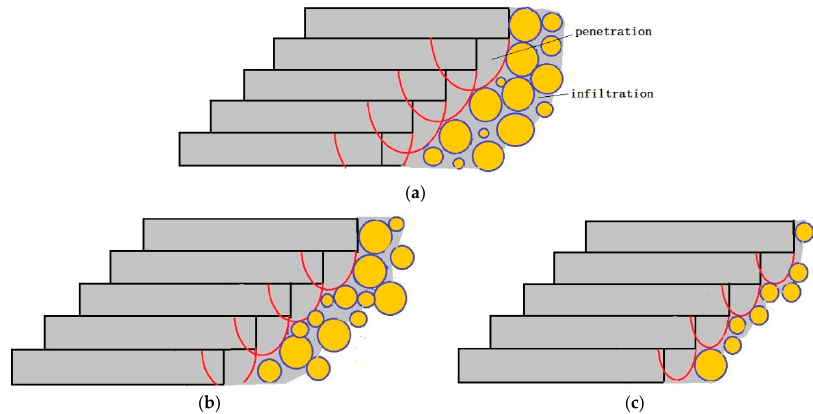
Figure 12. The schematic diagram of lower surface roughness caused by laser penetration and